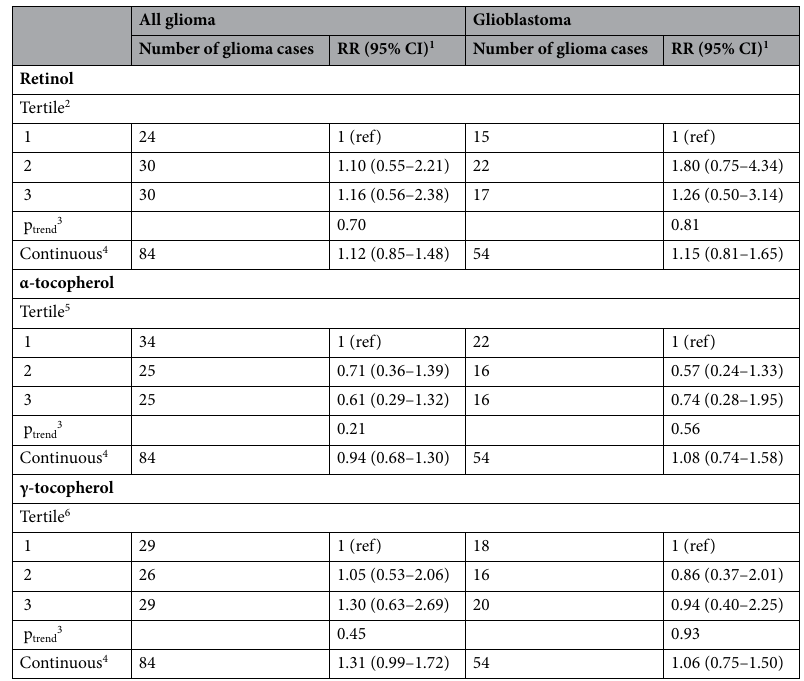
Table 3. Association between circulating retinol, α- and γ-tocopherol and glioma risk in the Nurses’ Health Study and Health Professionals Follow-Up Study. CI confidence interval, RR risk ratio. 1 In addition to conditioning on matching factors in the NHS and HPFS (year of birth, fasting status, month of blood collection, and race), adjusted for body mass index (continuous), smoking status (never, past, and current), and circulating cholesterol (continuous). 2 Median plasma retinol for each tertile in the NHS and HPFS: 1.74, 2.16, and 2.74 μmol/L. 3 The p-value for linear trend across tertiles was the p-value of the ordinal variable constructed by assigning medians to all participants in the tertiles. 4 Results for continuous analyses for each standard deviation increment. 5 Median plasma α-tocopherol for each tertile in the NHS and HPFS: 29.66, 41.32, and 57.50 μmol/L. 6 Median plasma γ-tocopherol for each tertile in the NHS and HPFS: 2.94, 5.60, and 8.59